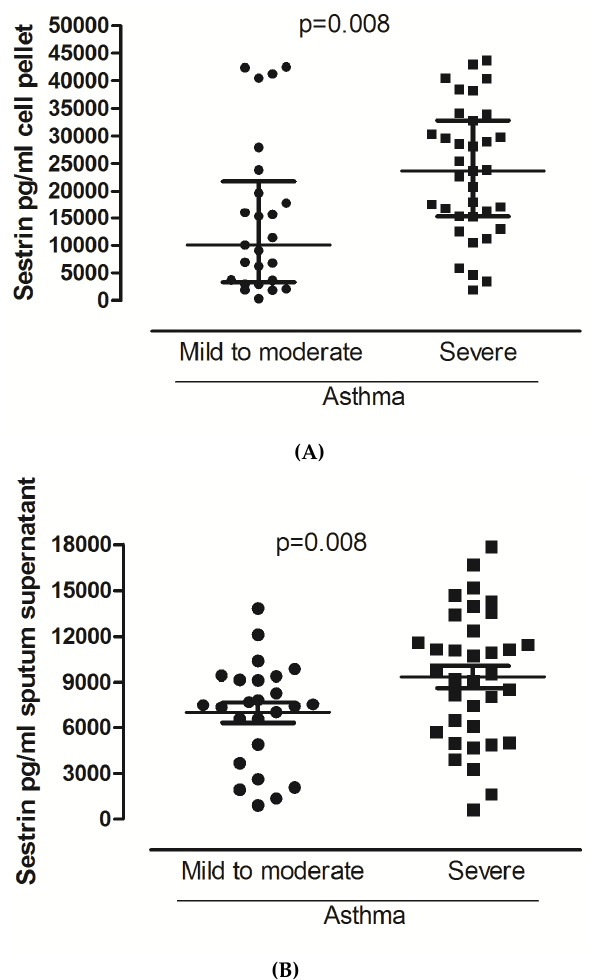
Figure 1. Sestrin 2 levels in patients with mild to moderate and severe asthma in cell pellets ( A ) and sputum supernatants ( B ). For data, see the table. Cell pellet SIRT1 mostly degraded, and SIRT1 at 120kDa was not detectable. Serum SIRT1 levels (expressed as optical density in Western blot) did not di ff er between patients with mild to moderate asthma and those with severe asthma (0.032 ± 0.02 vs. 0.047 ± 0.03, p = 0.414, Figure 2).